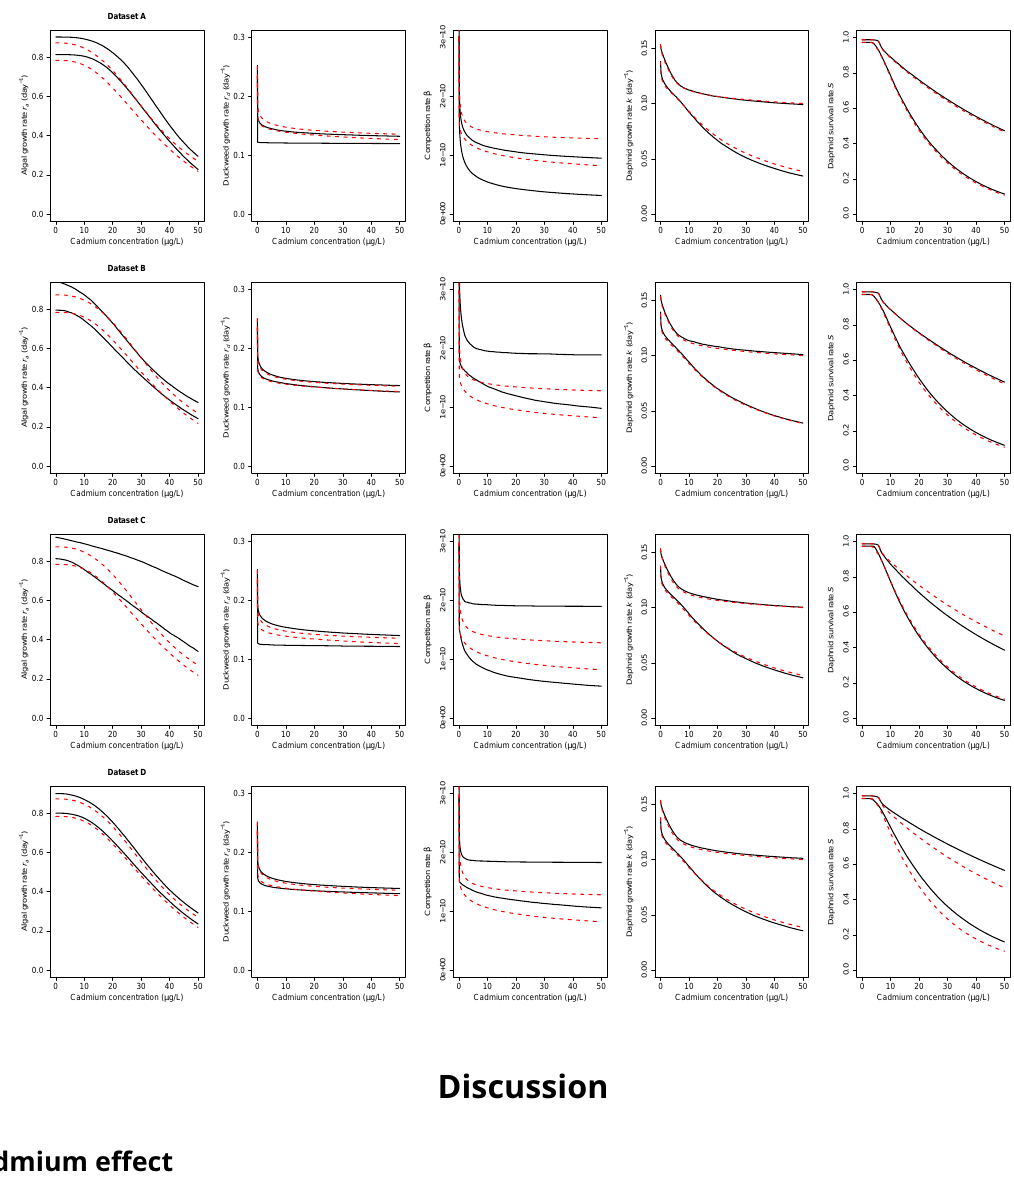
Figure 4. Comparison of stress functions obtained with complete and partial datasets. Plain black lines delimit the 95% credible bands for the stress functions obtained with the partial dataset, while red dotted lines delimit the 95% credible bands for the stress functions obtained with the complete